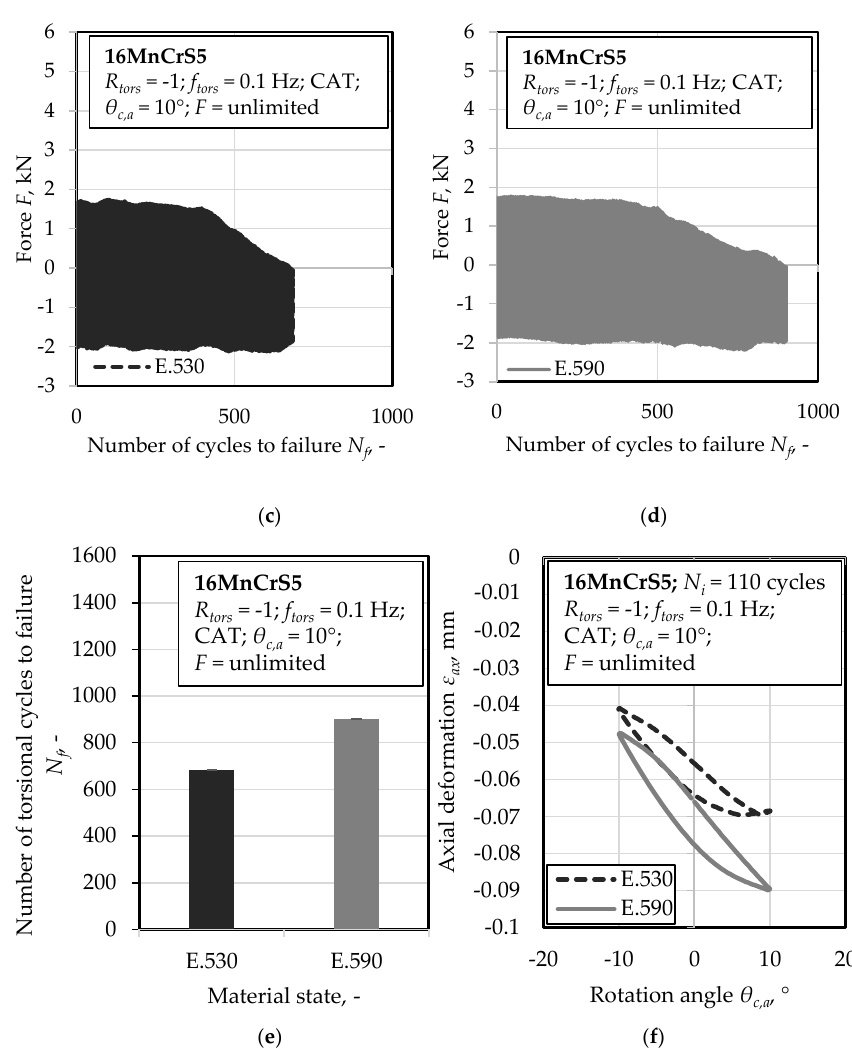
Figure 4. Fatigue performance for material states E.530 and E.590 in rotation angle control under torsional, constant amplitude load paths with regard to torque level for material state ( a ) E.530; ( b ) E.590; force level for material state ( c ) E.530; ( d ) E.590; ( e ) torsional cycles to failure; ( f ) axial deformation ε ax after an indicated number of torsional cycles during the ongoing lifecycle N i = 110 torsional cycles.